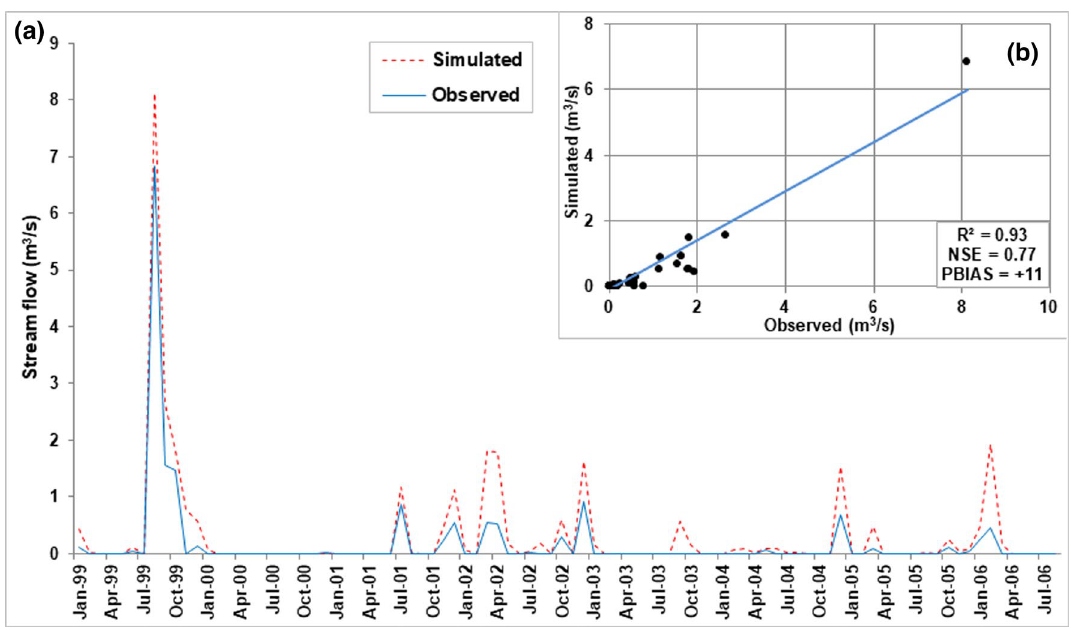
Fig. 5 a Observed and simulated monthly streamflow b Correlation of observed and simulated monthly streamflow during the validation